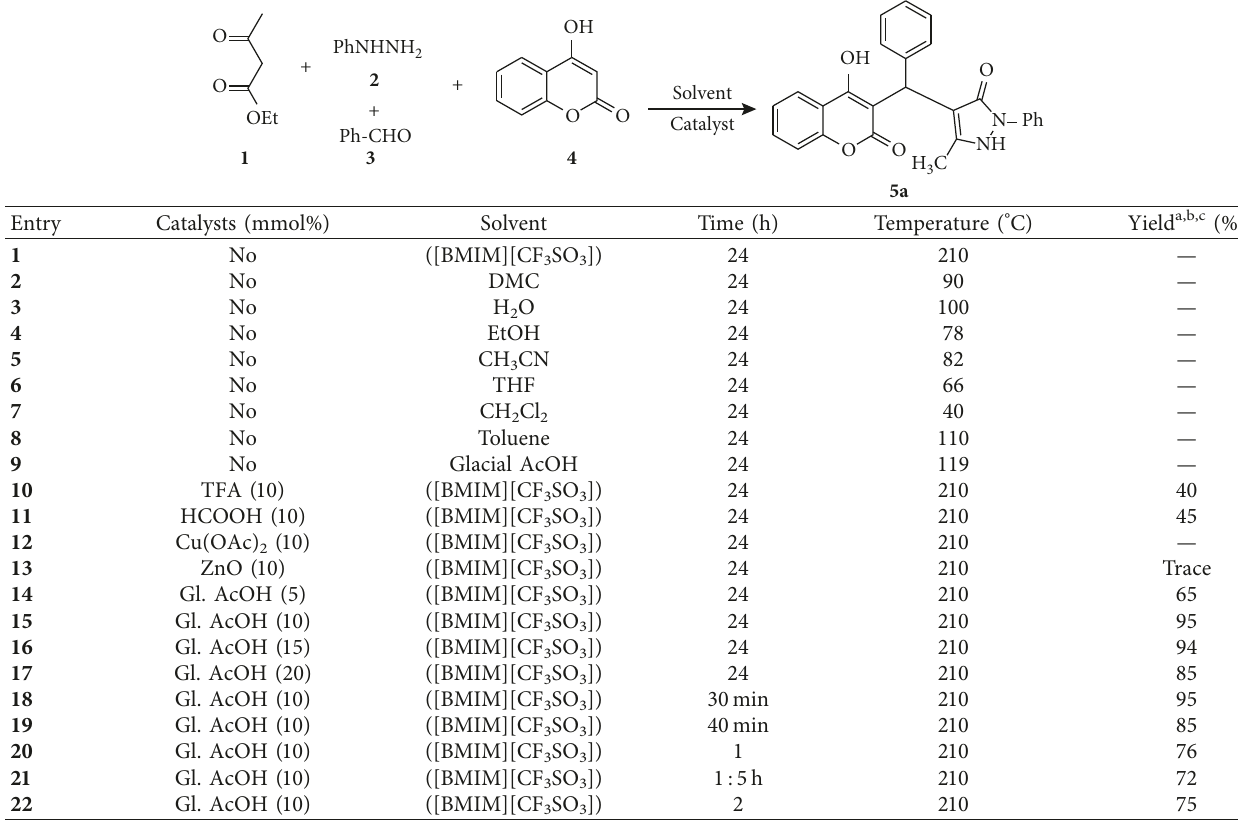
Table 1: Optimization of the conditions’ reaction using different